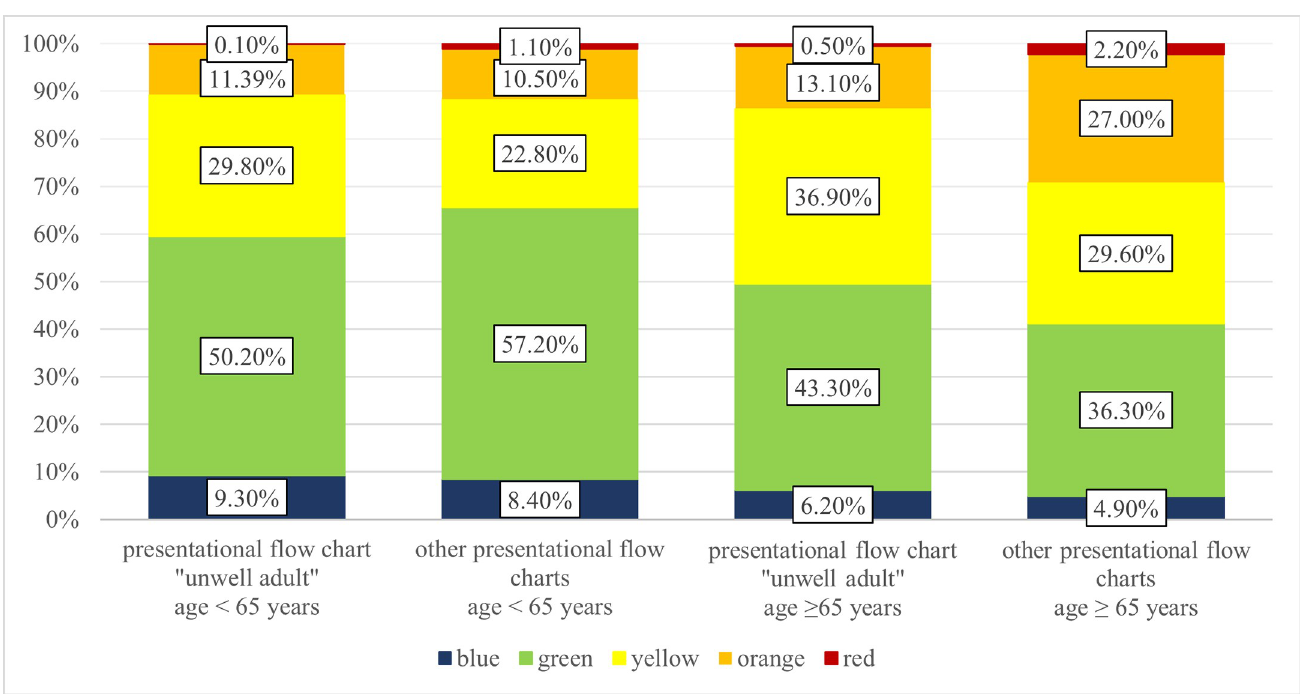
Fig 1. The different MTS urgency levels used in the presentational flow chart “unwell adult” vs. the other presentational flow charts, which were divided into two age categories (aged < 65 years and � 65 years).